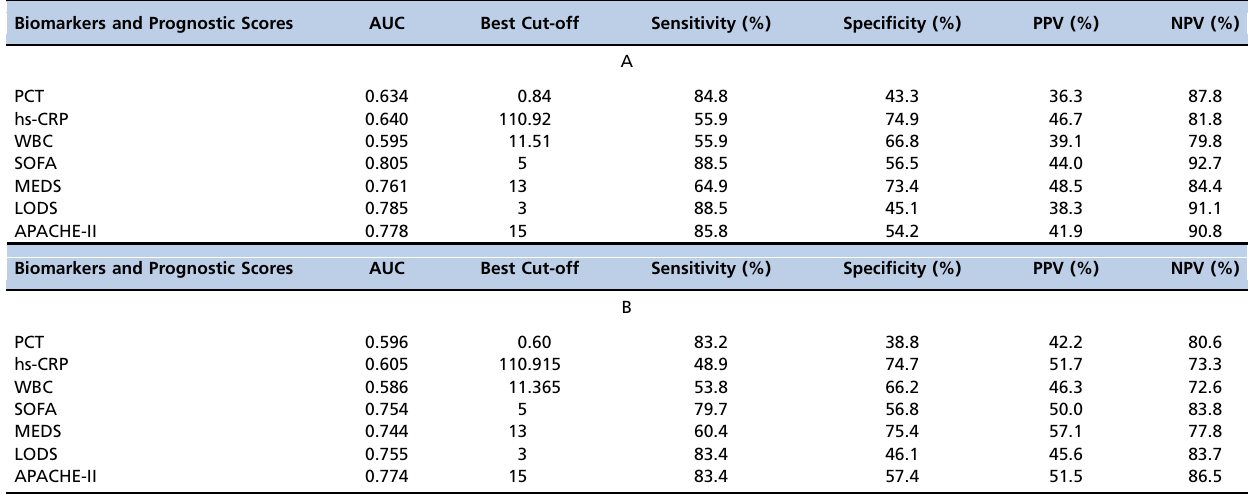
AUC, area under the curve; PPV, positive predictive value; NPV, negative predictive value; PCT, procalcitonin; hs-CRP, high-sensitivity C-reactive protein; WBC, white blood cell; SOFA, Sequential organ failure assessment; LODS, Logistic organ dysfunction system; MEDS, Mortality in emergency department sepsis; APACHE-II, Acute Physiology and Chronic Health Evaluation II. a specificity of 54.3%, and an NPV of 92.7% with GPB infections. Pairwise comparisons of the AUC for 60-day mortality were as follows: PCT versus hs-CRP, p =0.096; PCT versus WBC, p =0.101; and hs-CRP versus WBC, p =0.817. At a cut-off value of 0.92 ng/mL, PCT showed a sensitivity of 80.6%, a specificity of 58.3%, and an NPV of 84.1% with GPB infections (shown in Table 4). Figure 3-B, D show the ROC curves of PCT, hs-CRP, and WBC for early and late mortality prediction of patients with sepsis